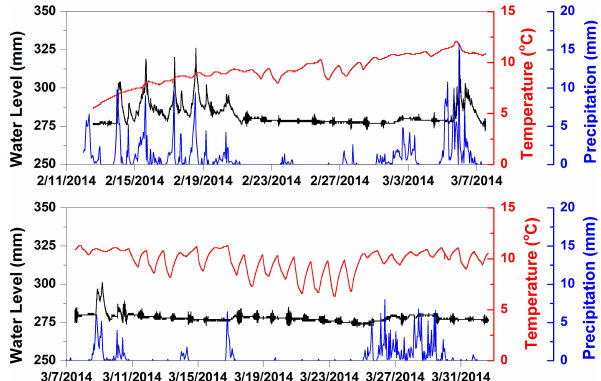
Figure 7. Long-term field monitoring data from the pressure trans- ducer installed at the Alsea site on Oregon Highway 34. The black, red, and blue lines represent water level, temperature, and hourly precipitation, respectively. The continuous monitoring was divided into two plots to show more details.